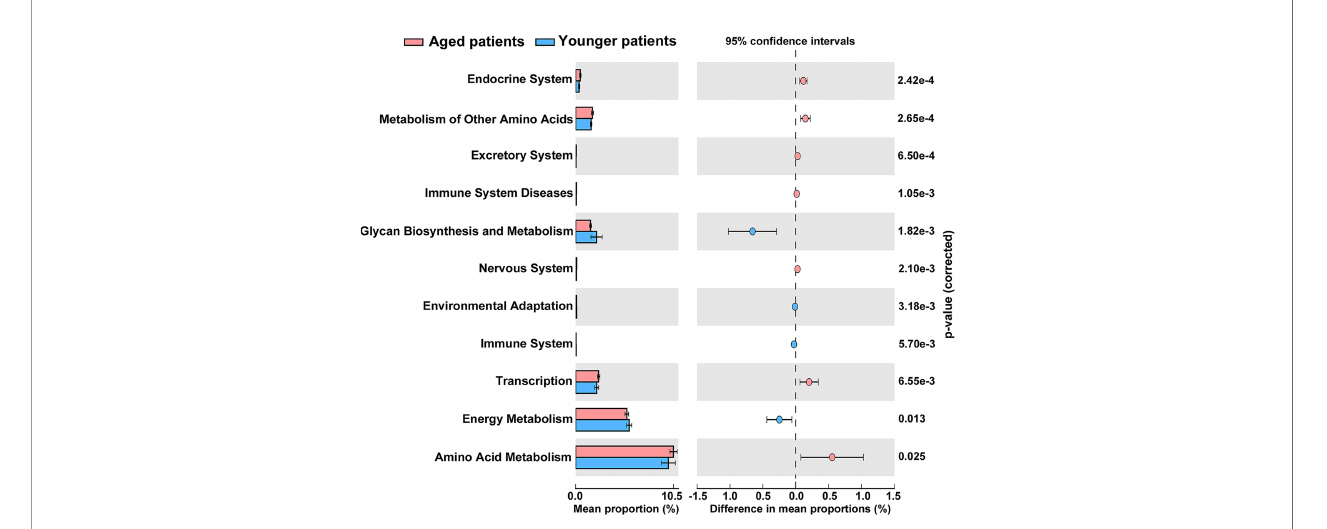
FIGURE 6 | Signi fi cant differences in abundance offunctional properties of the bacterial community regarding the super pathways between aged and younger patients.